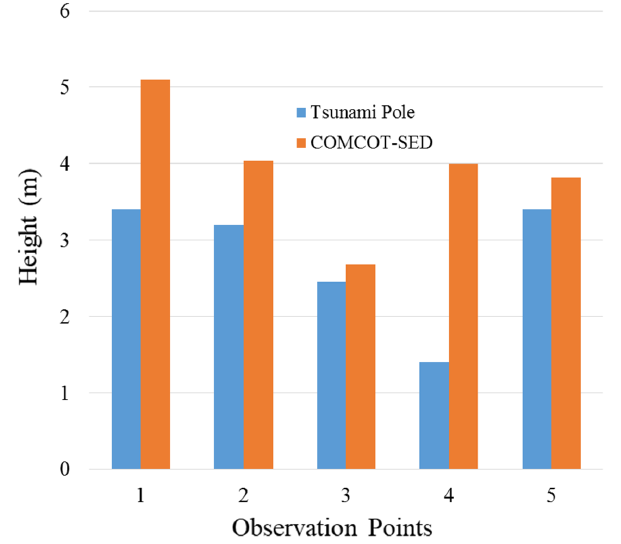
Figure 7. The calculated tsunami heights (orange bar) and surveyed data (blue bar) in Banda Aceh